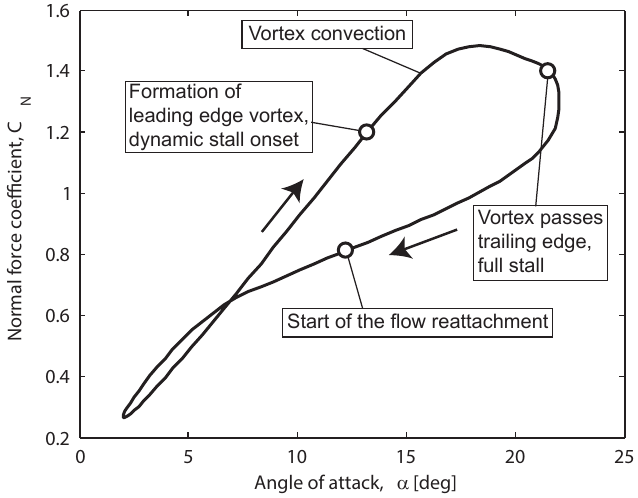
Figure 7. Normal force coefficient for the pitching NACA0021 airfoil, α = 12+10 sin ( ω t ) , k = 0 . 06 , M = 0 . 1 , c = 0 . 55 m , where k , M and c are the reduced frequency, the Mach number and the chord length